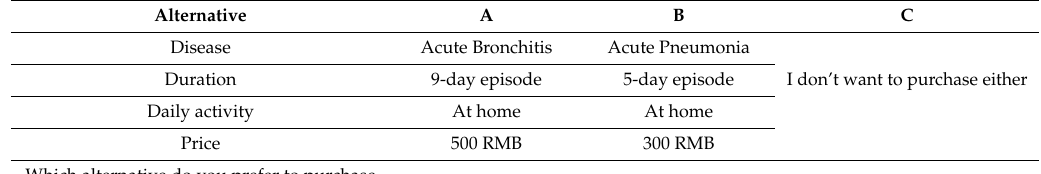
Table A6. Choice set